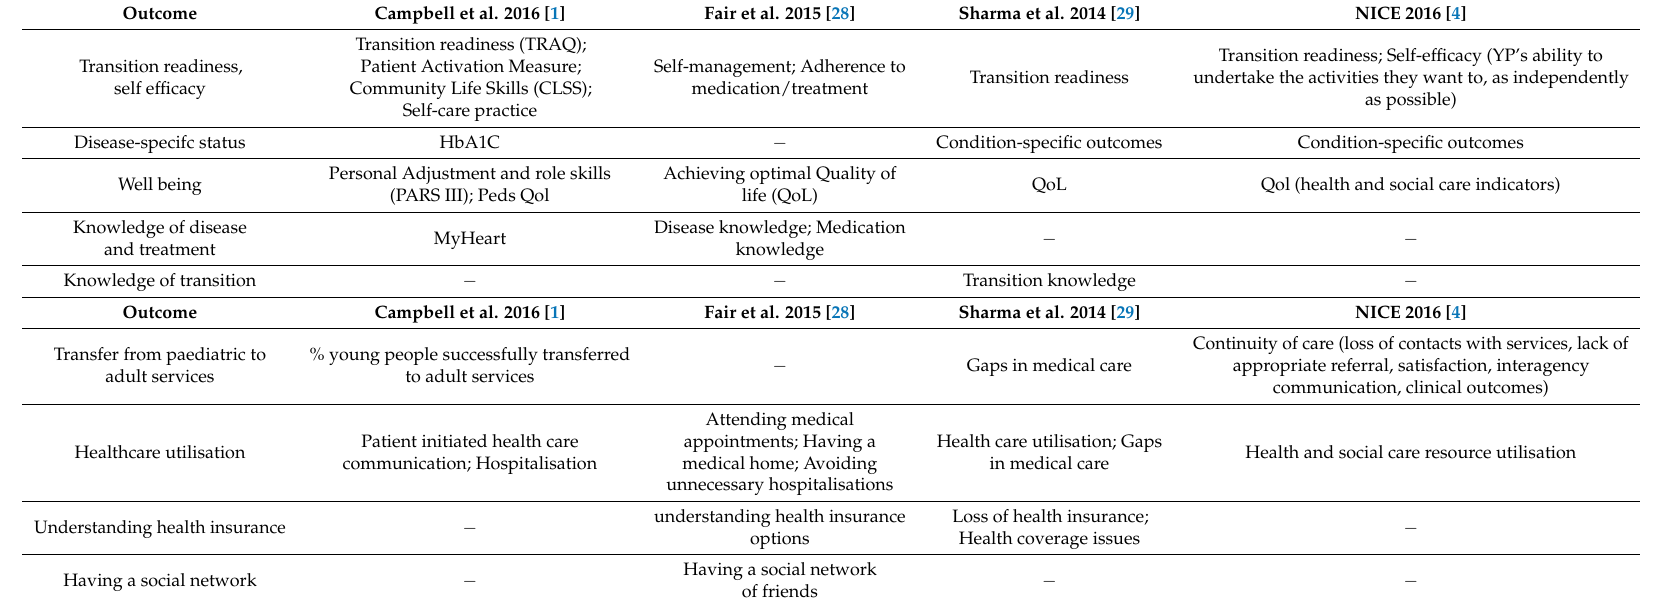
Table 4. Summary of the proposed outcome indicators of transition in the current